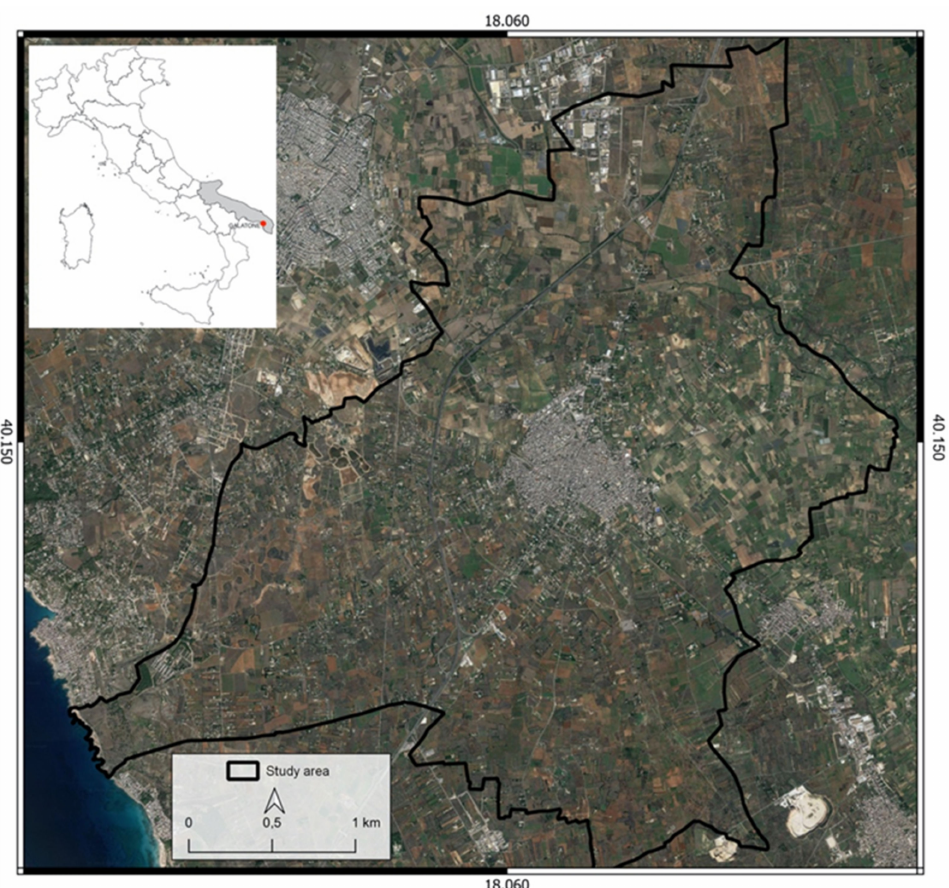
Figure 2. Study area: urban landscape of Galatone